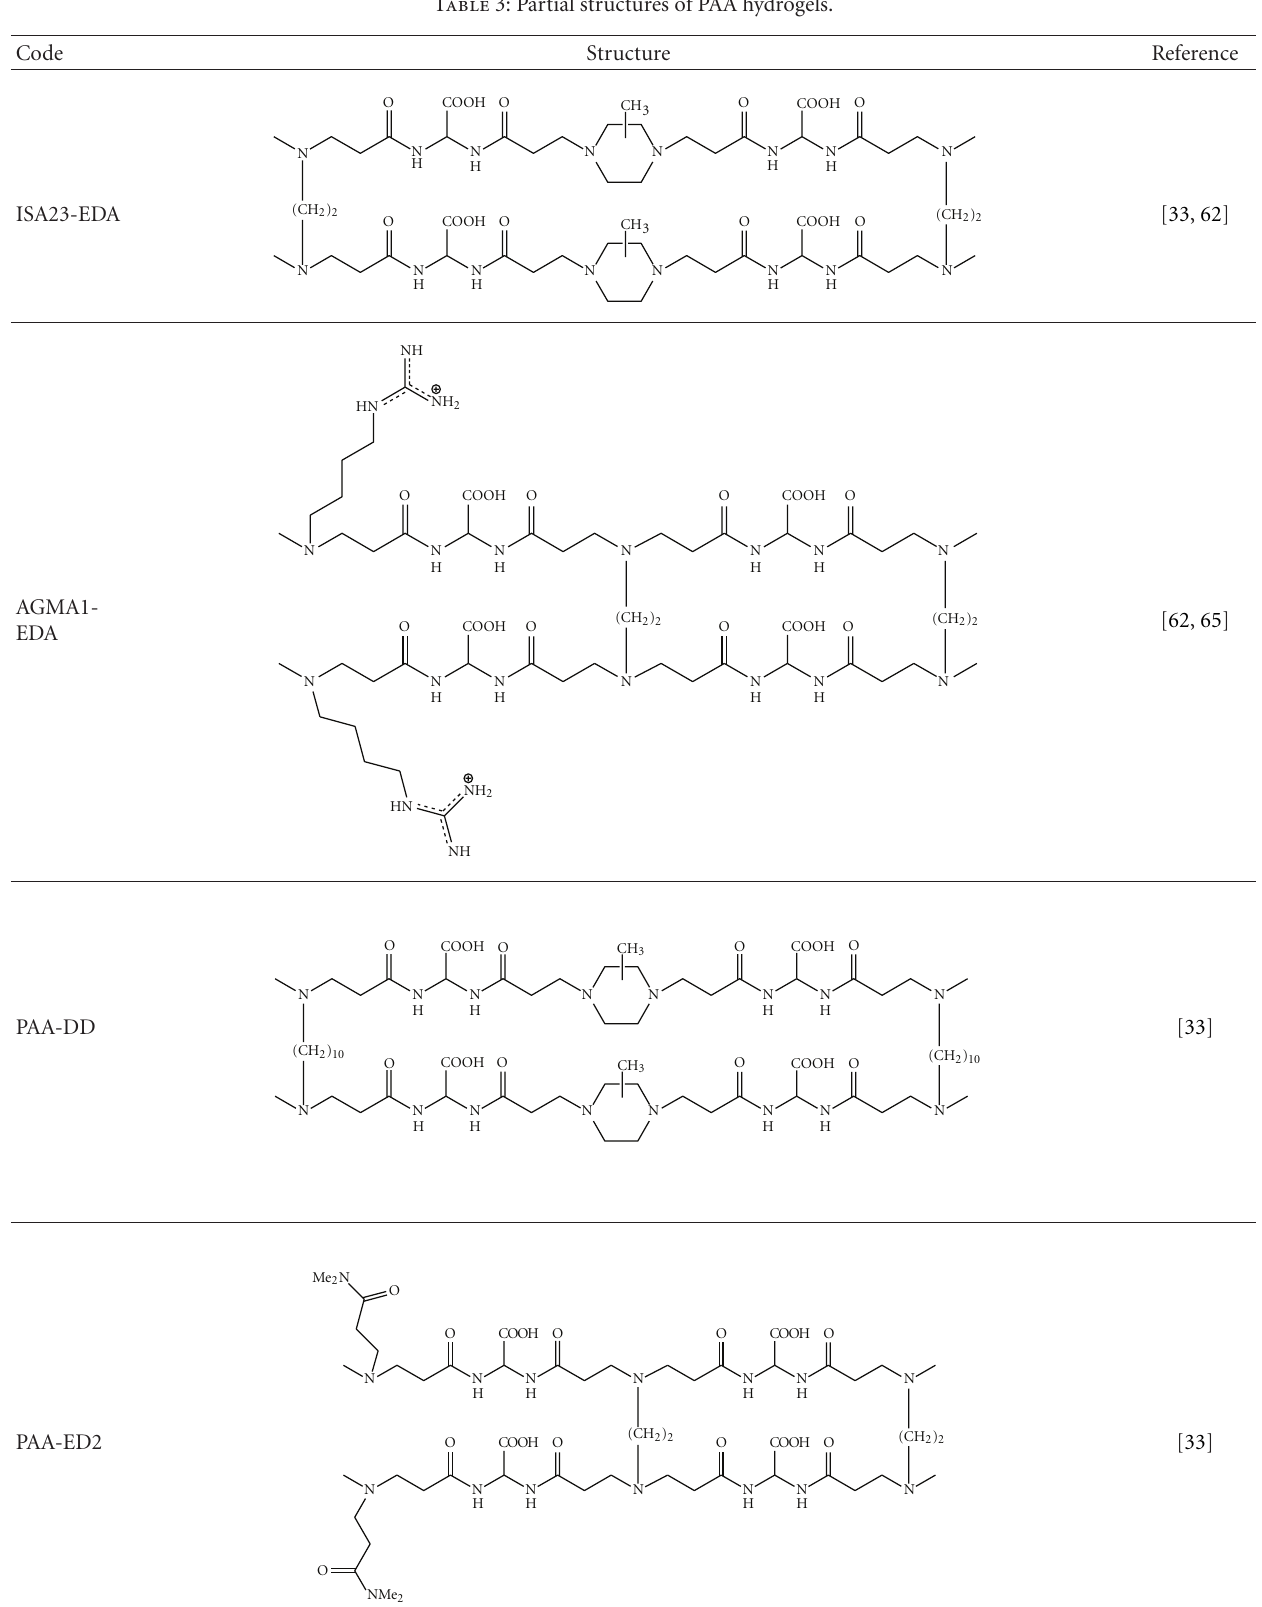
Table 3: Partial structures of PAA